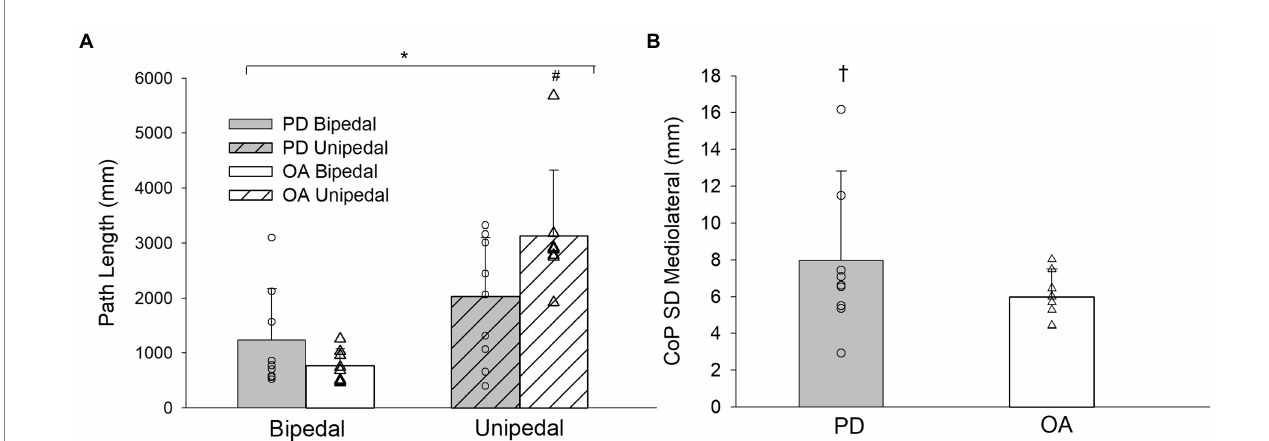
FIGURE 3 (A) Path length for older adults with PD and older adults without PD during bipedal and unipedal stance collapsed across conditions. (B) center of pressure (CoP) standard deviation (SD) mediolateral for older adults with PD and older adults without PD collapsed across conditions. PD, older adults with Parkinson’s disease; OA, older adults without PD. *, unipedal greater than bipedal; # , greater in older adults without PD during unipedal stance. † , group main effect for CoP SD Mediolateral ( p = 0.06).